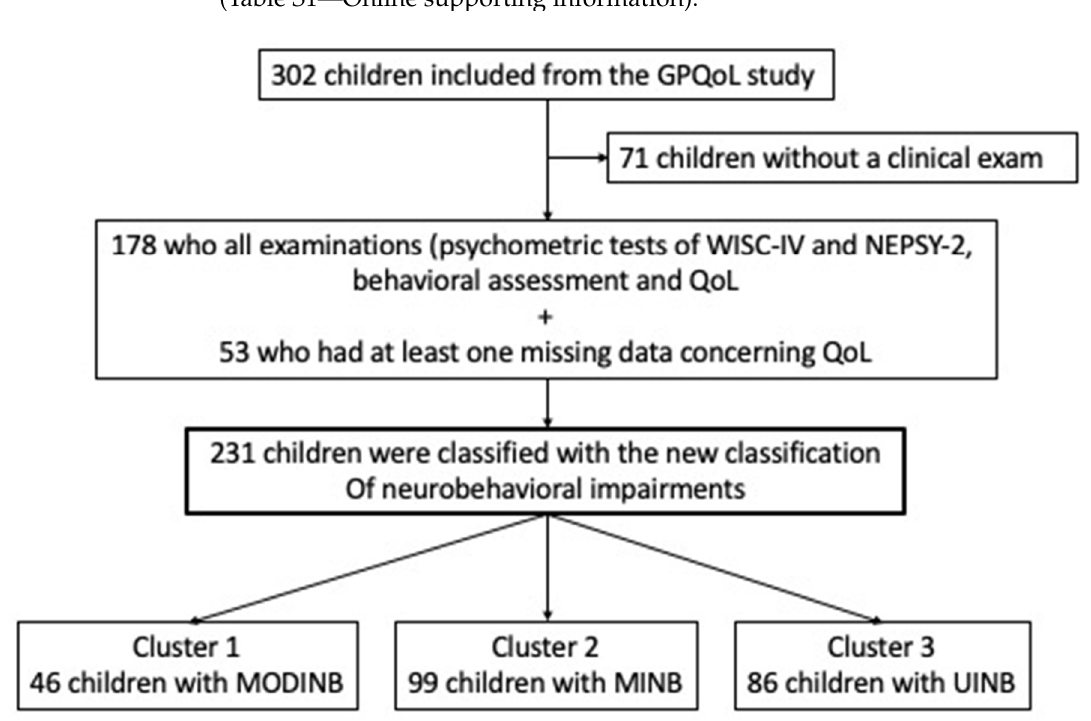
Figure 1. Study population’s flow chart. Note: Quality of Life (QoL); Cluster 1: Moderate Impaired NeuroBehavior (MODINB); Cluster 2: Minor Impaired NeuroBehavior (MINB); Cluster 3: UnImpaired NeuroBehavior (UINB).